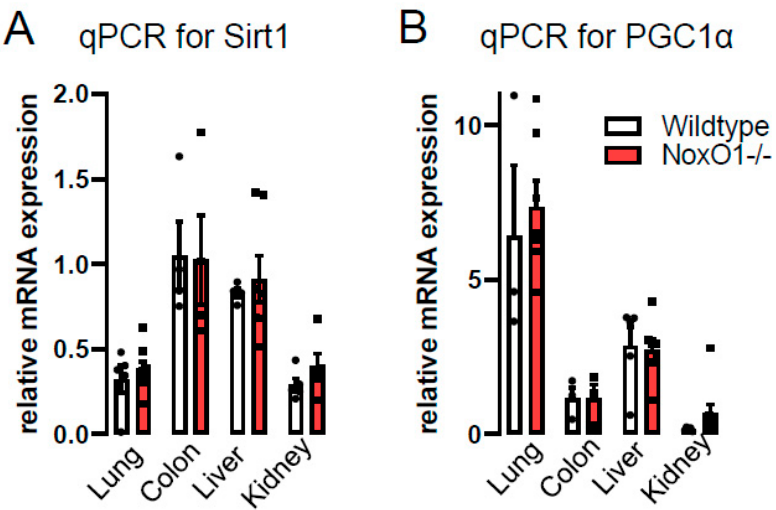
may prolong the life of a NoxO1 knock out mouse.